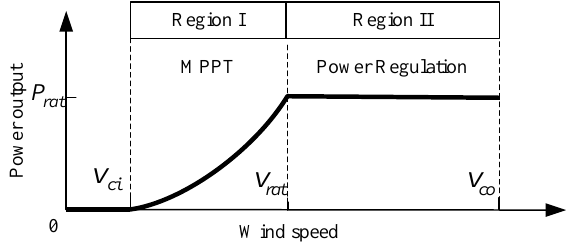
Figure 2. An ideal power curve for a variable-speed variable-pitch wind turbine.